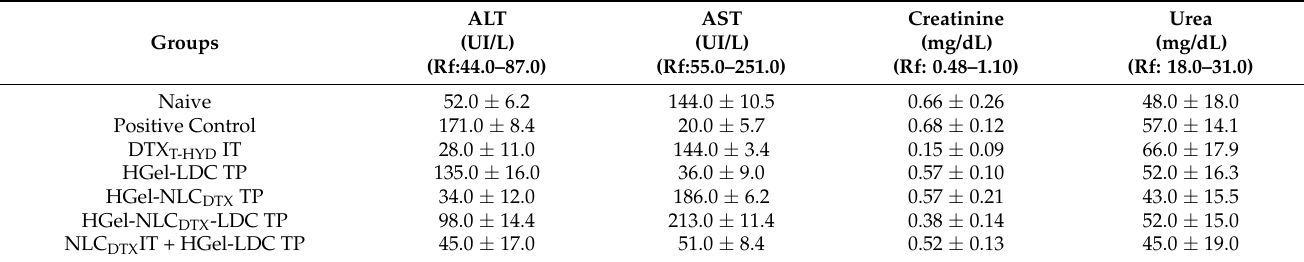
(Table 5). Pathological processes in the liver can increase the activity of serum ALT and AST, caused by infections or chemical agents, such as antineoplastic drugs [79] while changes in serum levels of creatinine and urea are indicative of renal overload, nephrotoxicity and acute renal failure [80,81]. Overall, from a clinical point of view the levels of ALT, AST, urea, or creatinine remained normal after all treatments. Table 5. Biochemical parameters in the serum of female C57BL/6J mice, after treatment with PBS (positive control), free docetaxel (DTX T-HYD ) and hydrogel formulations (HGel-LDC, HGel-NLC DTX TP, HGel-NLC DTX -LDC TP and NLC DTX IT + HGel-LDC TP).